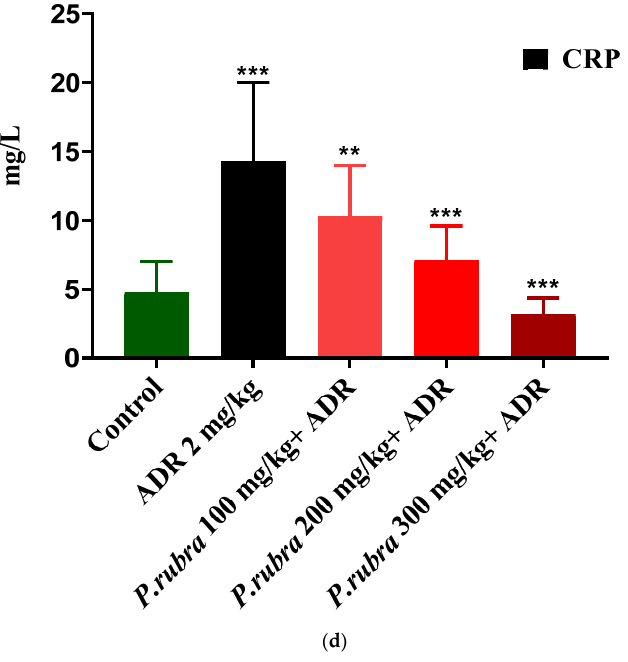
Figure 4. Cardioprotective effect of three doses of aqueous-methanolic leaf extract of P. rubra on the cardiohepatic biomarkers, ALP ( a ), AST ( b ), ALT ( c ) and CRP ( d ), against ADR-induced MI . One-way ANOVA and Dunnett’s multiple comparison test were performed (** p < 0.005, *** p < 0.001 & ns p > 0.005, n = 5). Effect on Heart to Bodyweight Ratio ADR noticeably increased the ratios regarding the control group. All three groups treated with P. rubra reduced their heart to bodyweight ratios less than the ADR-intoxicated group (Figure 5).